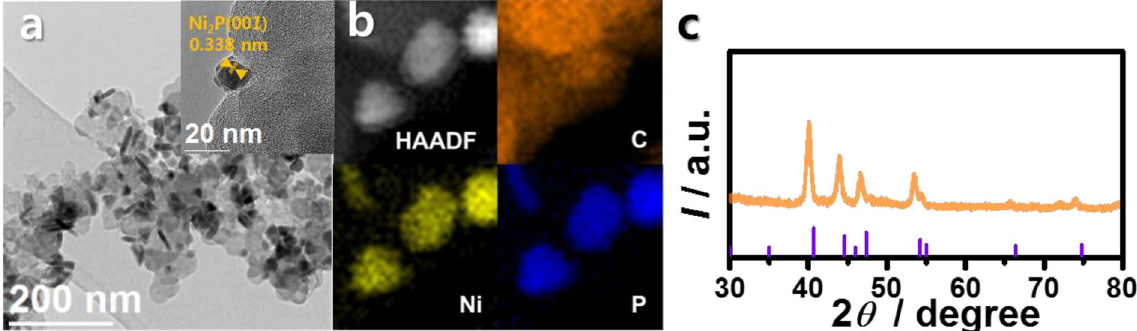
Figure 2. ( a ) Transmission electron microscopy (TEM) images of Ni 2 P/C, ( b ) high-angle annular dark field (HAADF, left) image and corresponding elemental mappings (C, Ni, and P) of Ni 2 P/C using energy dispersive X-ray spectroscopy (EDS), and ( c ) X-ray diffraction (XRD) pattern of Ni 2 P/C (purple line: JCPDS 03-0953).